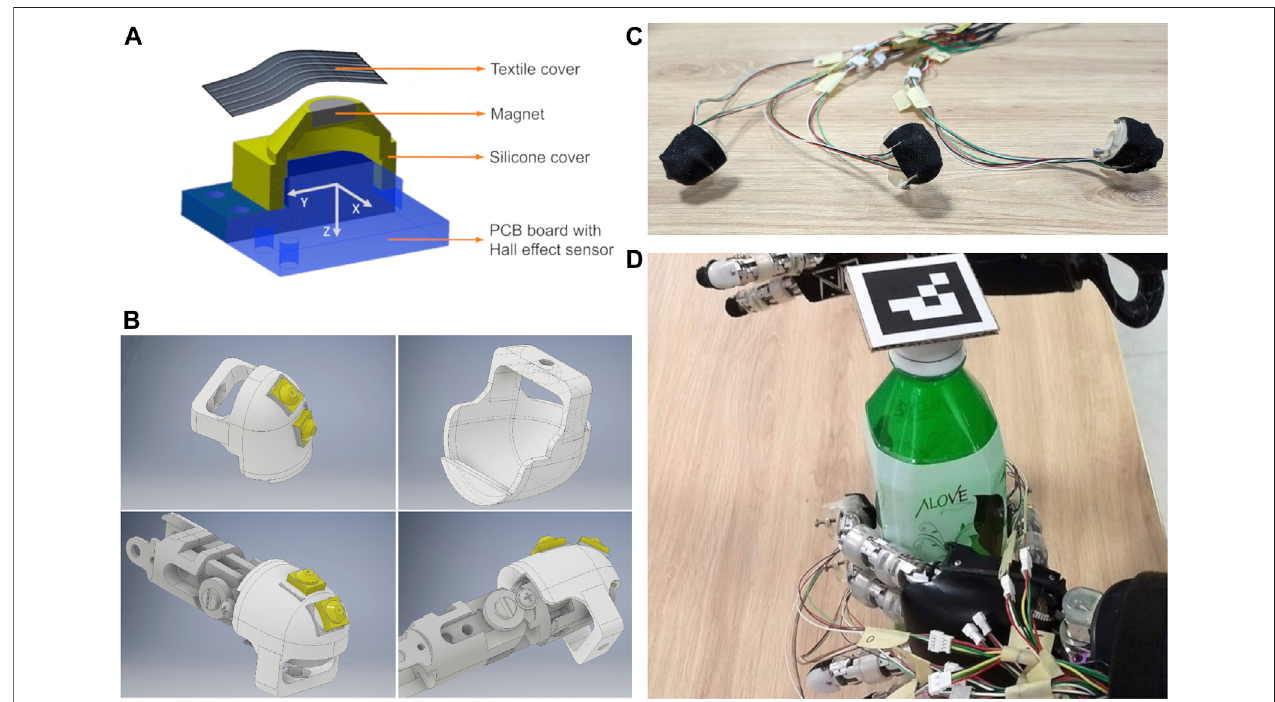
FIGURE 1 | In (A) , the exploded view of the sensing module. In (B) , the CAD model of the fi ngertip adapter for the iCub fi nger hosting two sensing modules. In (C) , the fi nalassembled fi ngertipadapterswiththegriptapecover.In (D) ,theexperimentalsetupwiththeiCubhumanoidrobotlefthandequippedwithuSkindeformablesoft tactile